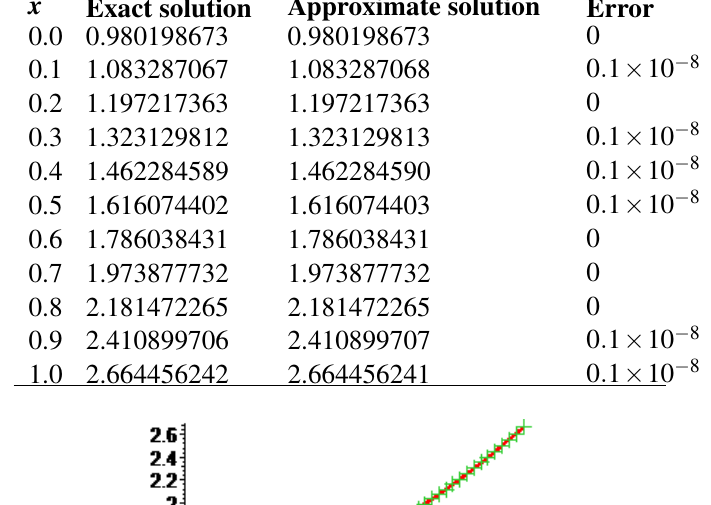
Table 3 Exact solution, approximate solution, and error values for t = 0 . 01